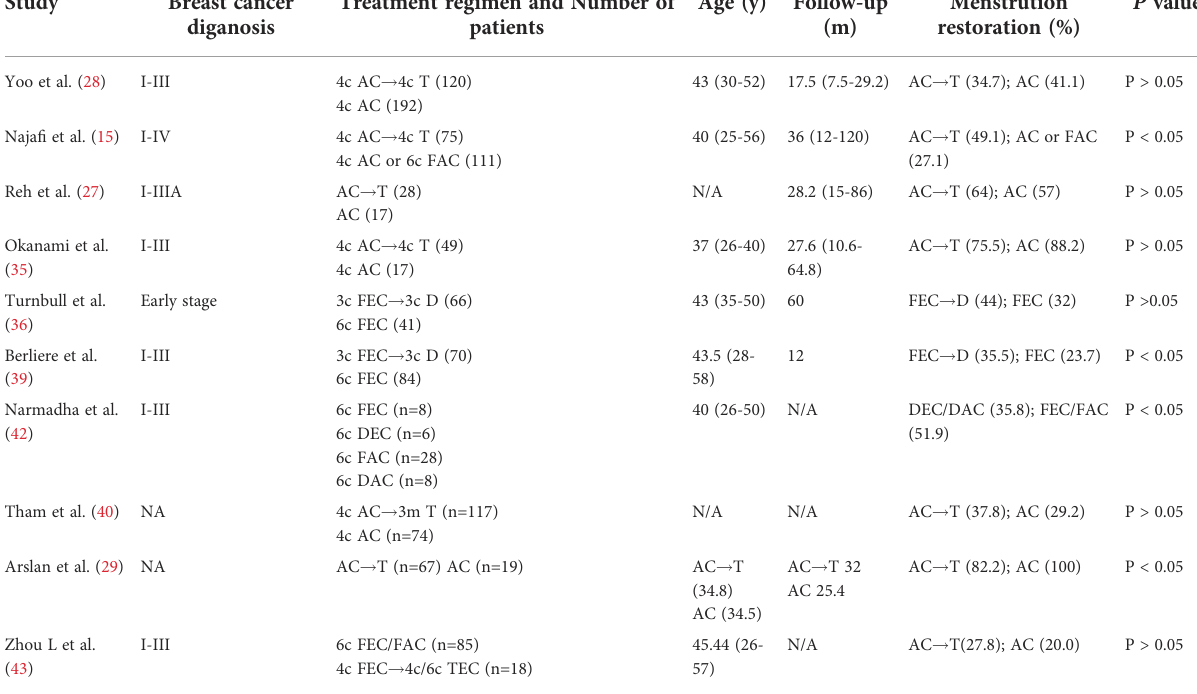
TABLE 3 The percentage of menstruation restoration after taxane-based